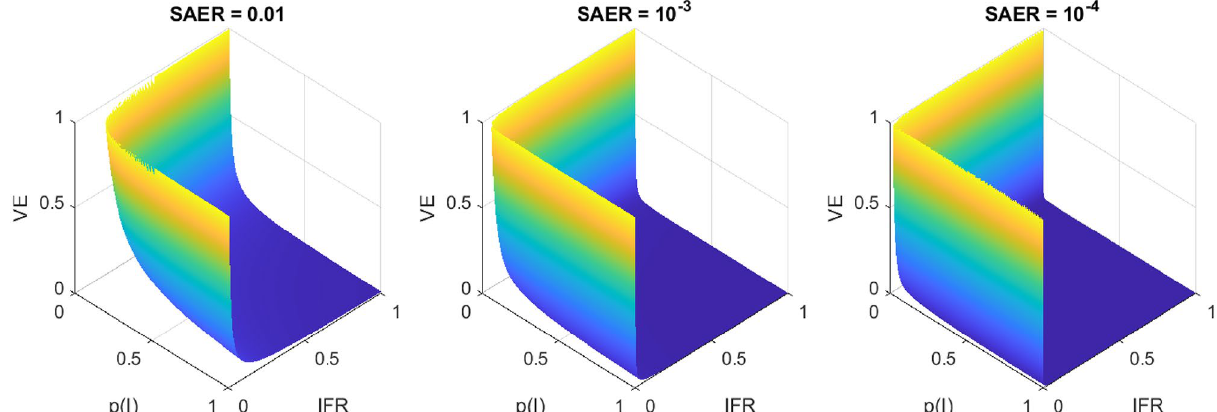
Figure 1. Surfaces of clinical equipoise for vaccination (Utility = 0) in terms of probability of infection (P(I)), Infection Fatality Rate (IFR) and Vaccine Efficacy (VE) for Serious Adverse Event Rate (SAER) = 0.01 (l), 10 − 3 (c), and 10 − 4 (r). The volume above this surface is where Utility > 0, thus vaccination is beneficial, and vice versa.